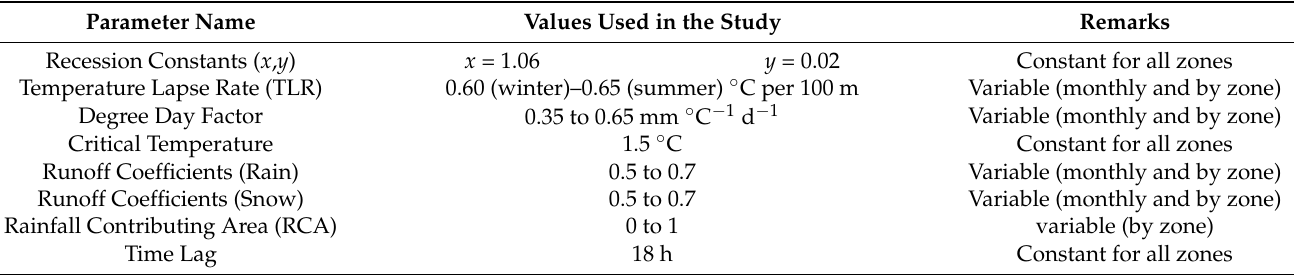
Table 1. Values of calibration parameters for SRM simulations.